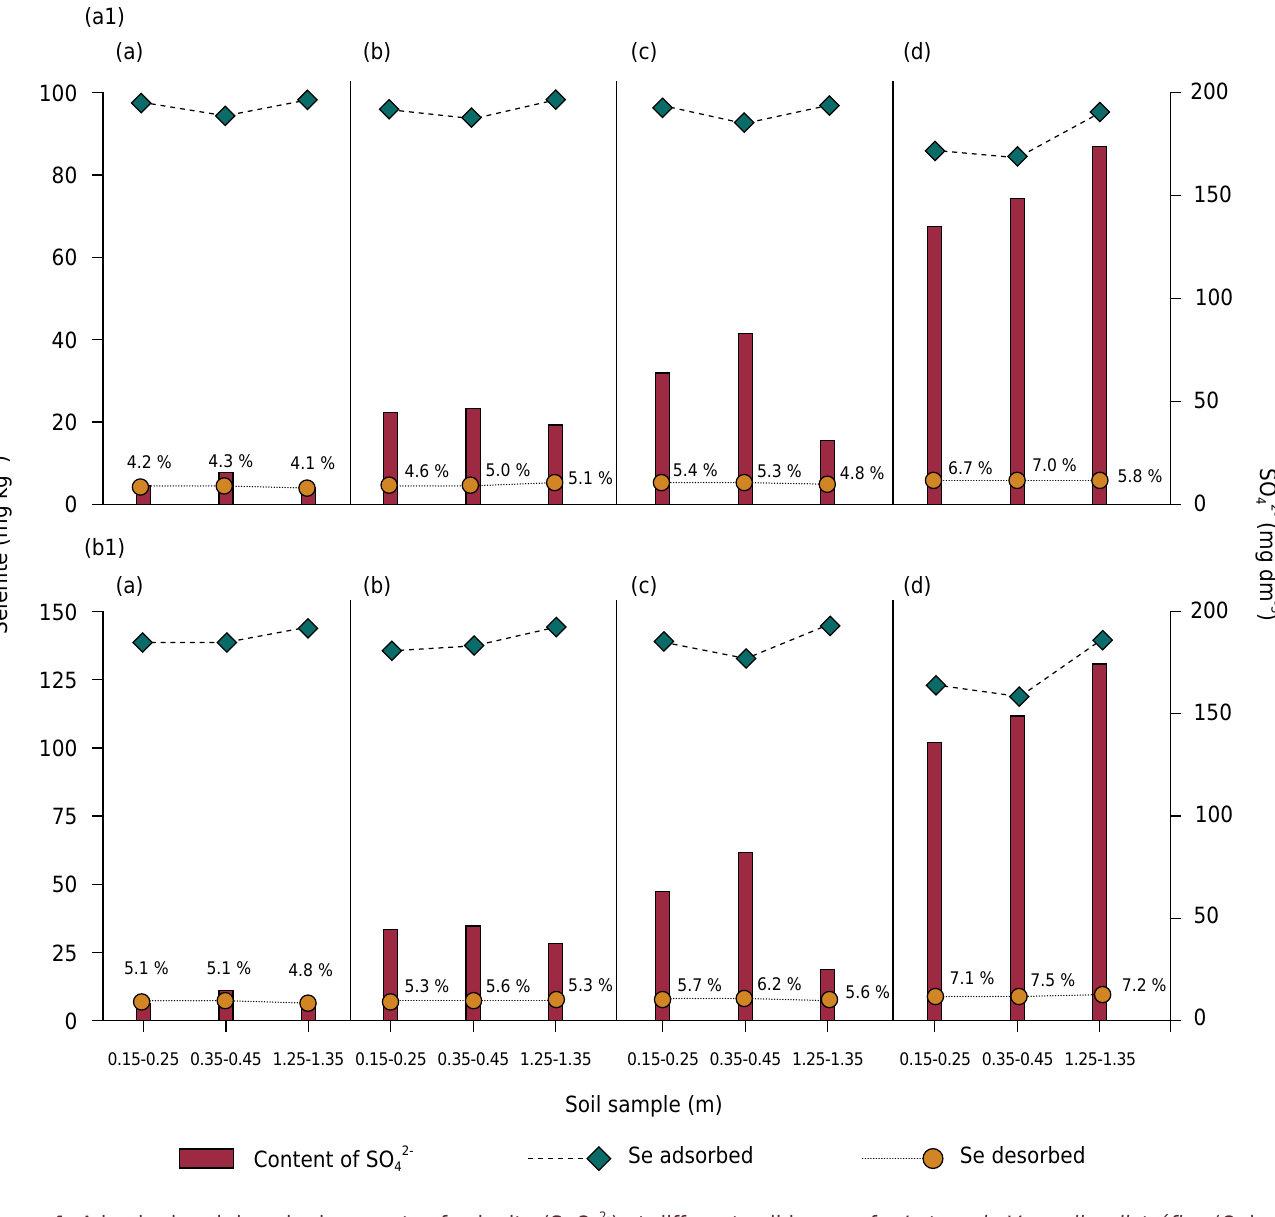
Figure 4. Adsorbed and desorbed amounts of selenite (SeO 32- ) at different soil layers of a Latossolo Vermelho distrófico (Oxisol). The percentages shown above the desorption points refer to the desorbed percentages as a function of the adsorbed amount. The letters (a), (b), (c), and (d) correspond respectively to the rates of phosphogypsum applied to the soil, as follows: 0, 7, 14, and 56 t ha -1 . (a1) and (b1) refer to SeO 3 2- doses of 10 and 15 mg L -1 ,